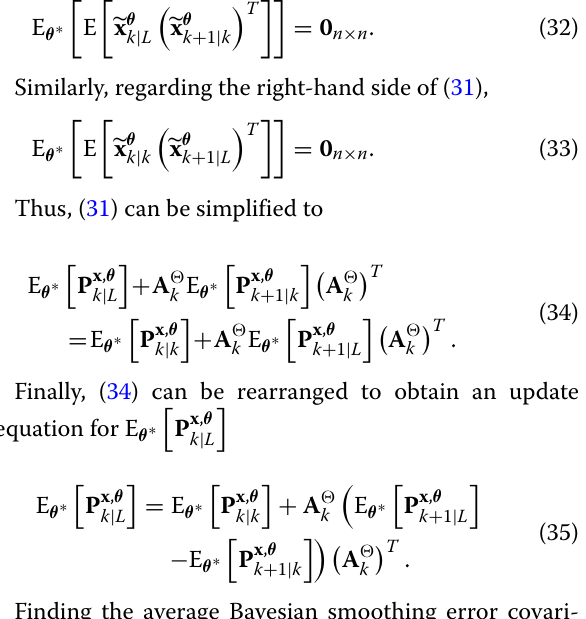
The forward step in the OBKS requires the posterior